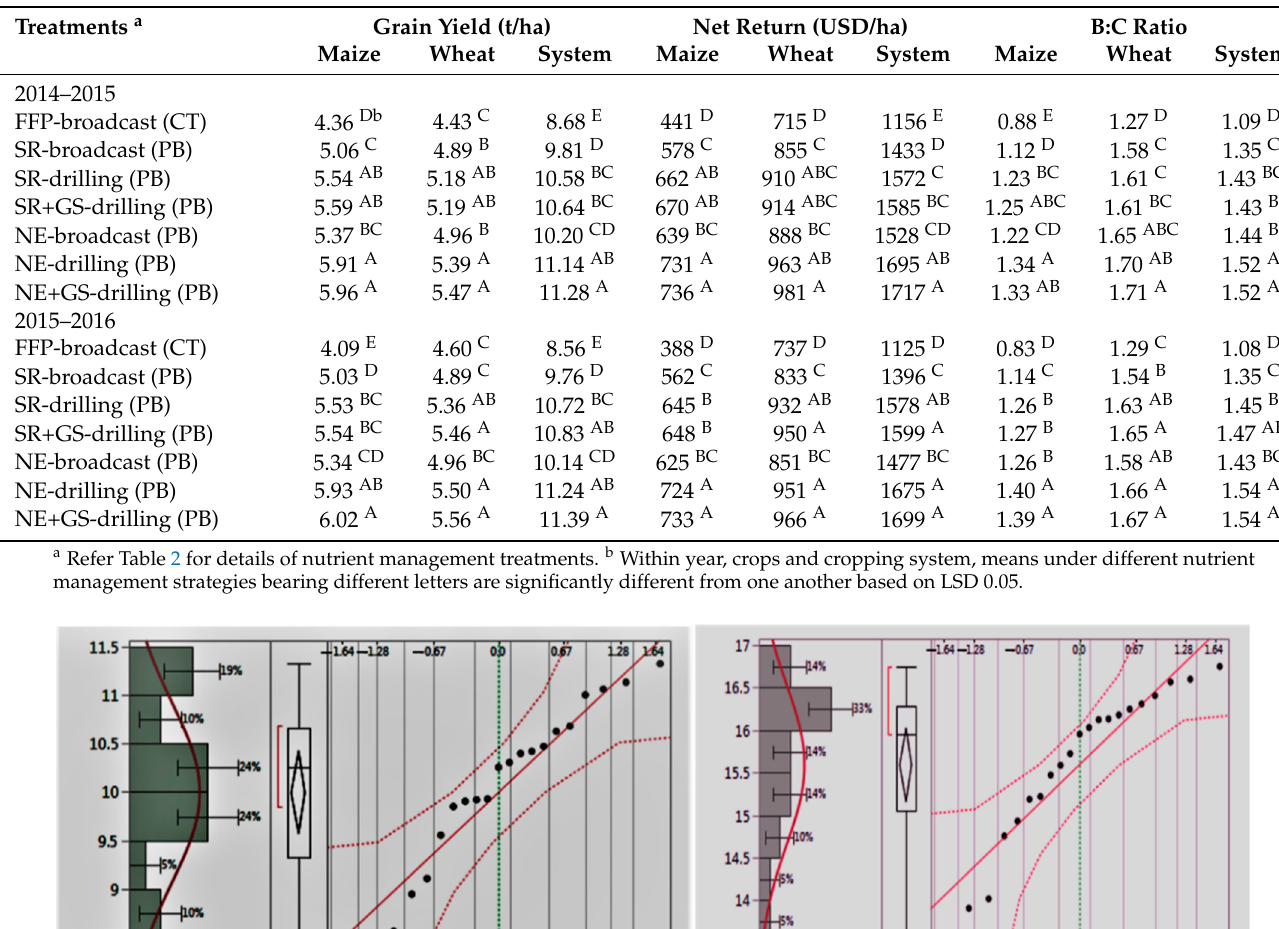
ratio as resulting from analysis of variance (ANOVA) during year 2014–2015 and 2015–2016 in maize-wheat system.